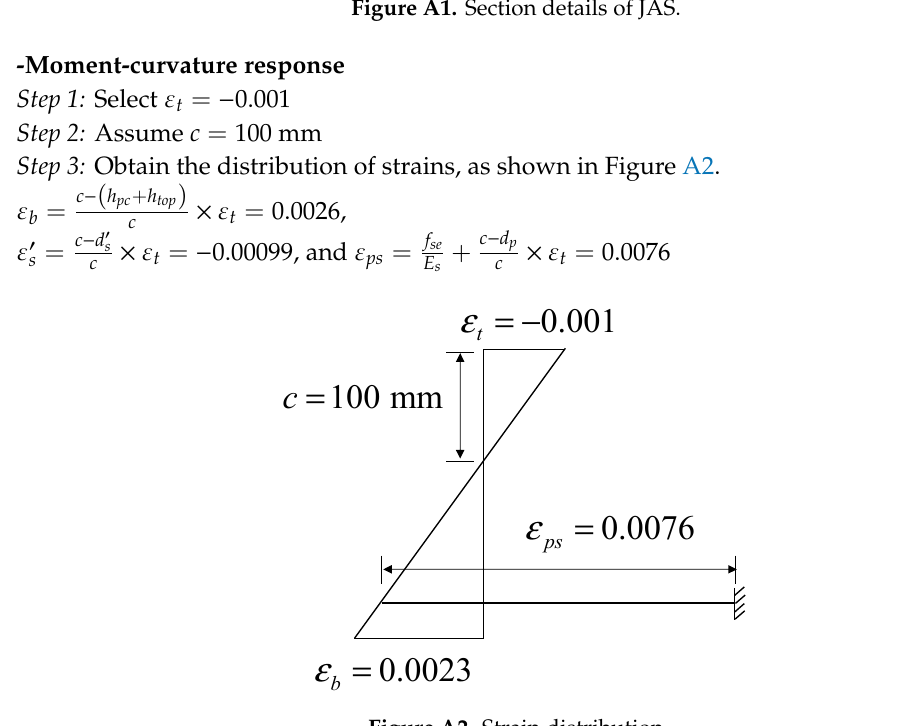
Figure A2. Strain distribution